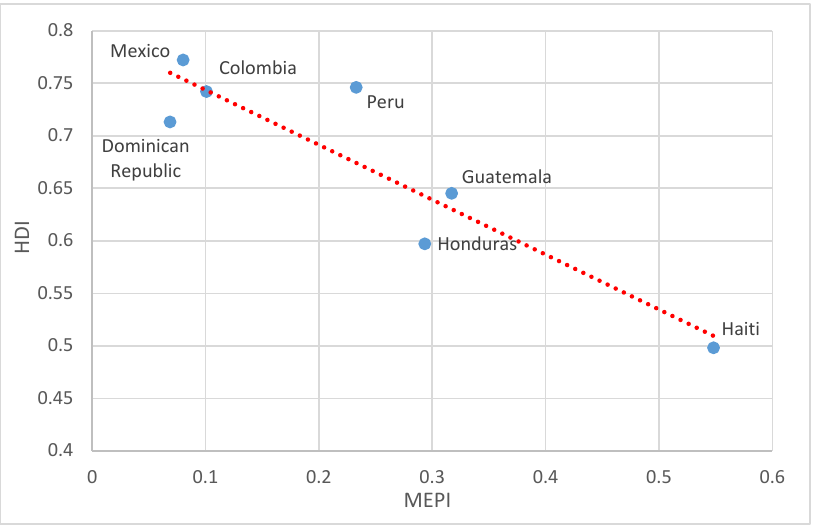
Figure 3. Relation between the MEPI and the HDI for the Latin American countries. Determination coefficient (r 2 ) equals to 0.83.